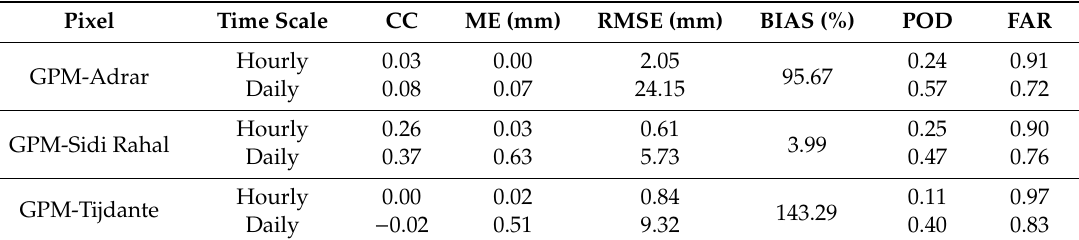
Table 4. Evaluation indices of IMERG-E at the grid-cell scale for the entire period (2011–2018). Pixel Time Scale CC ME